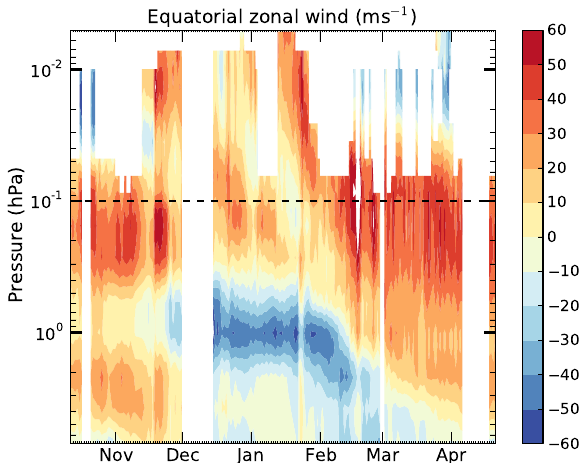
Fig. 12. The Semi-annual oscillation of the zonal winds over the equator ( ± 5 ◦ ). Red regions correspond to eastward (westerly) winds. The winds from both the ozone and HCl lines are combined in the plot when band-B is measured: information is for O 3 line be- low 0.1hPa (65km) and from HCl above. Information is from O 3 when only band-A is measured. Data with a line-of-sight orientation between ± 10 ◦ from the zonal direction are used.